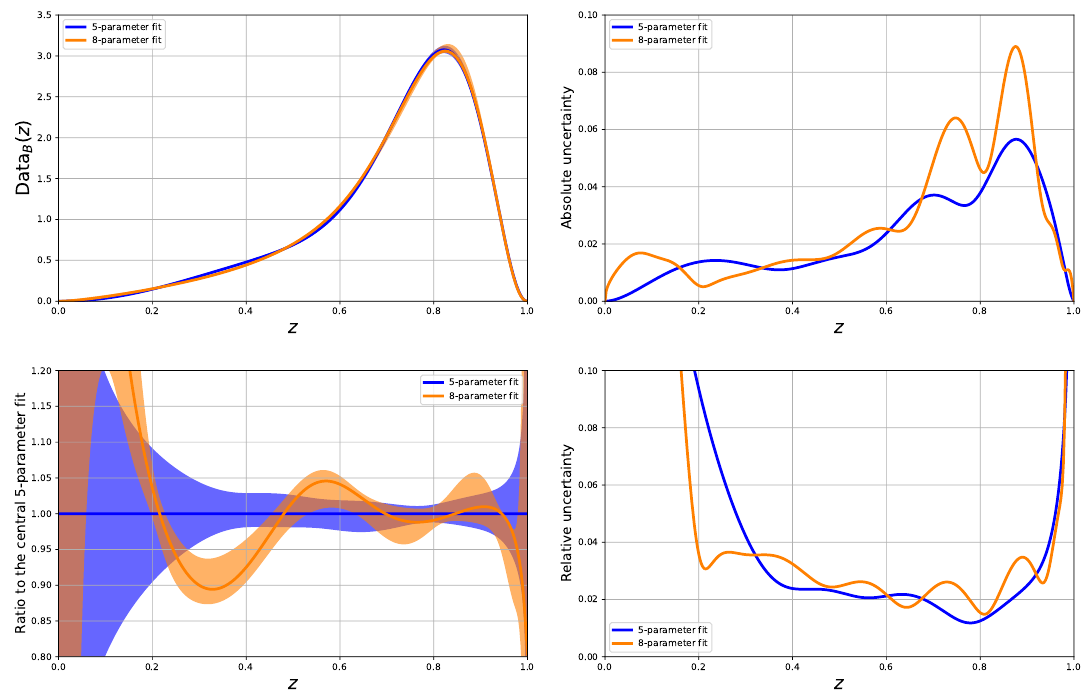
Figure 3 . Comparison of the 5-parameter (blue) and 8-parameter (orange) fits for the distribution Data ( z ) . Shown are the absolute distributions (top left) and their ratio (bottom left) as well B as their absolute (top right) and relative (bottom right) uncertainties. The uncertainty bands correspond to the root mean square (r.m.s.) of the set of 100 data